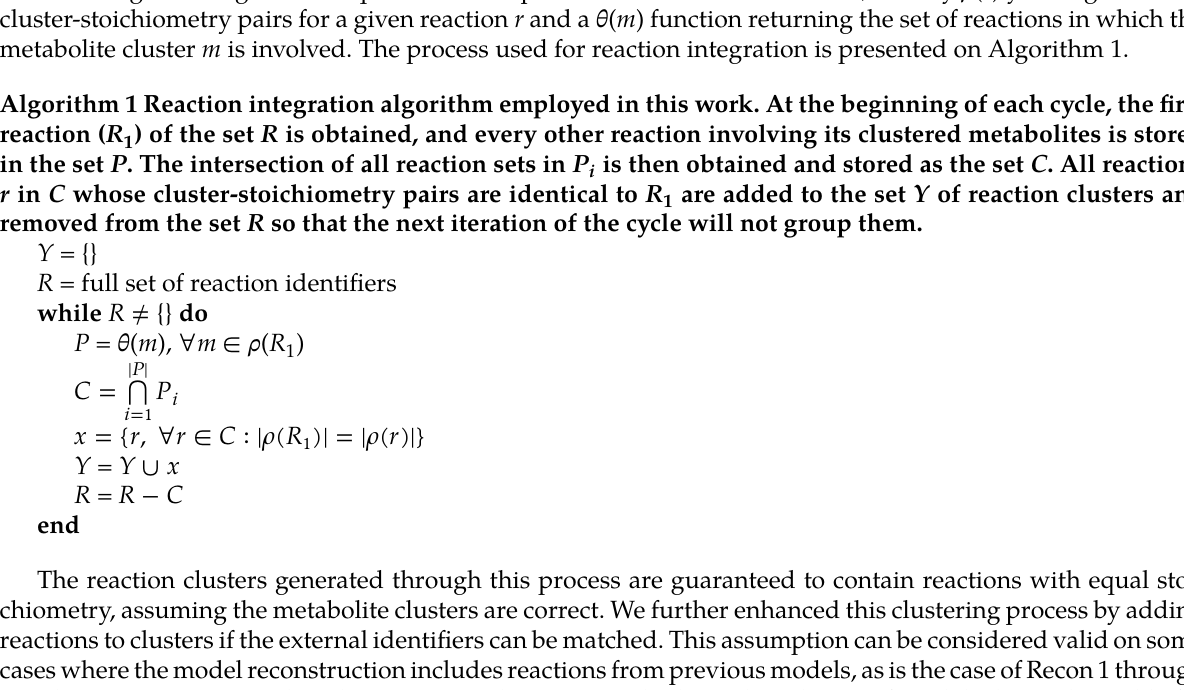
Figure 3: Data representation on the Neo4J database graph: the database is separated in two main levels: database and integration nodes. Database information is loaded into metabolite nodes that contain properties with metabolite infor- mation on the database node level; the integration process connects metabolite nodes representing the same metabolite information into cluster nodes that are present at the integration node